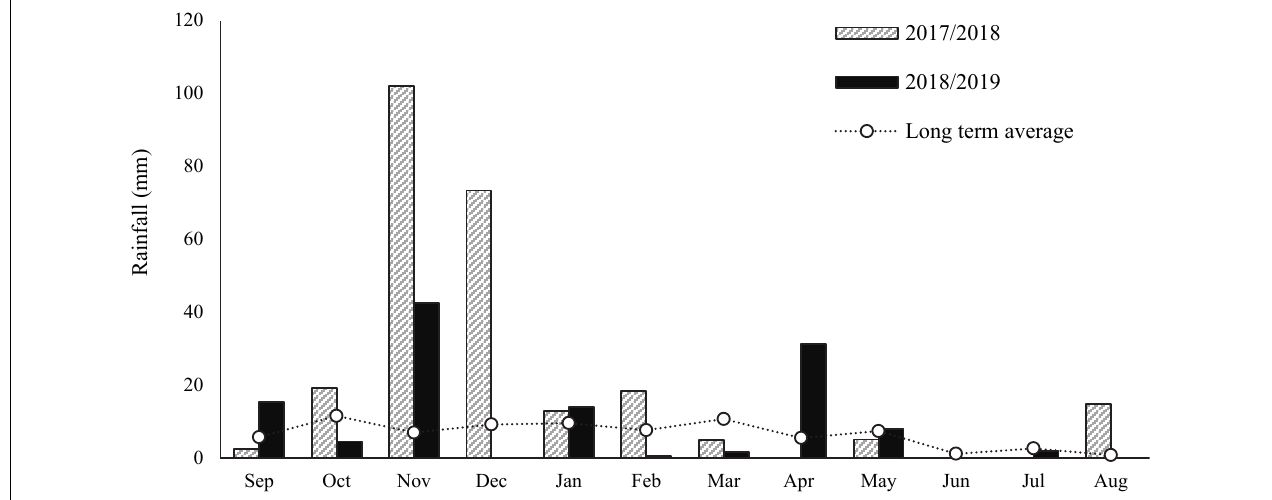
FIGURE 1 | Amount and distribution of rainfall during 2017–2018 and 2018–2019 and the long-term average (20 years) monthly rainfall data in Tataouine, Tunisia.